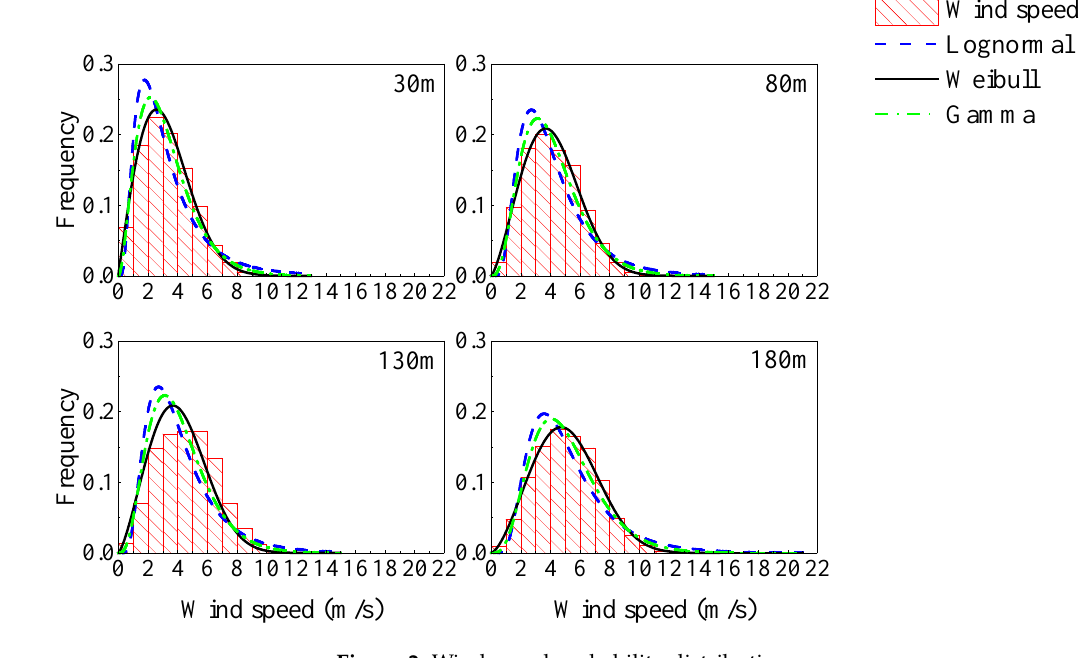
Figure 2. Wind speed probability distribution. Table 3. Goodness-of-fit test of distribution model.